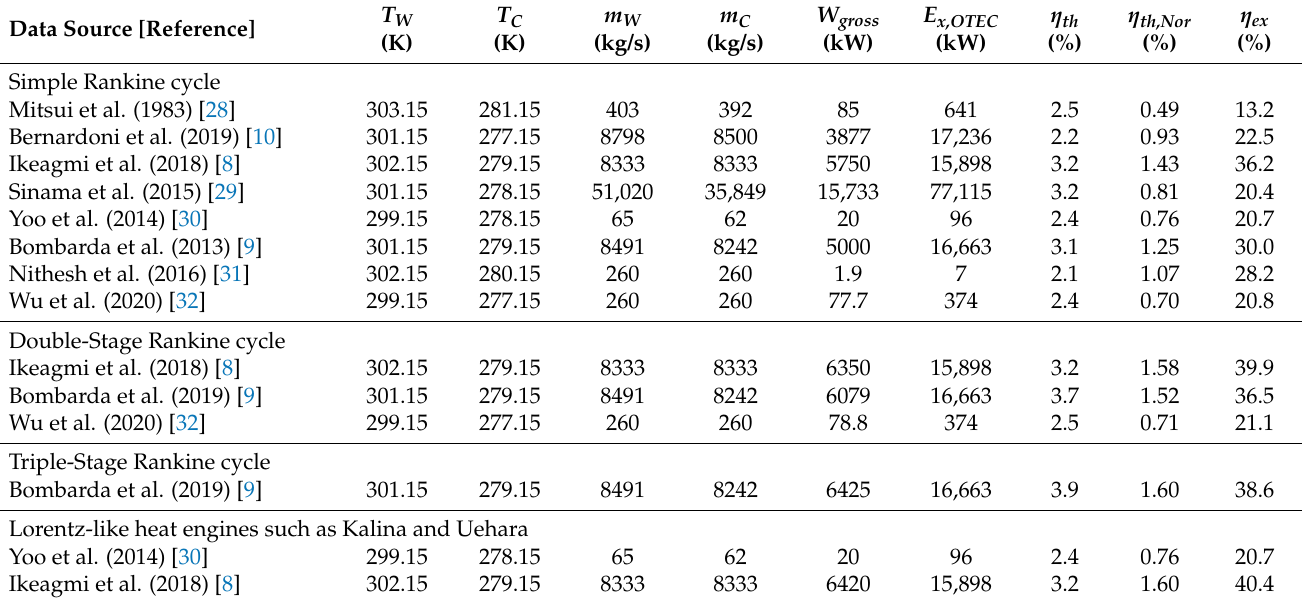
Table 1. Design condition and the evaluation using conventional and FTT efficiencies.